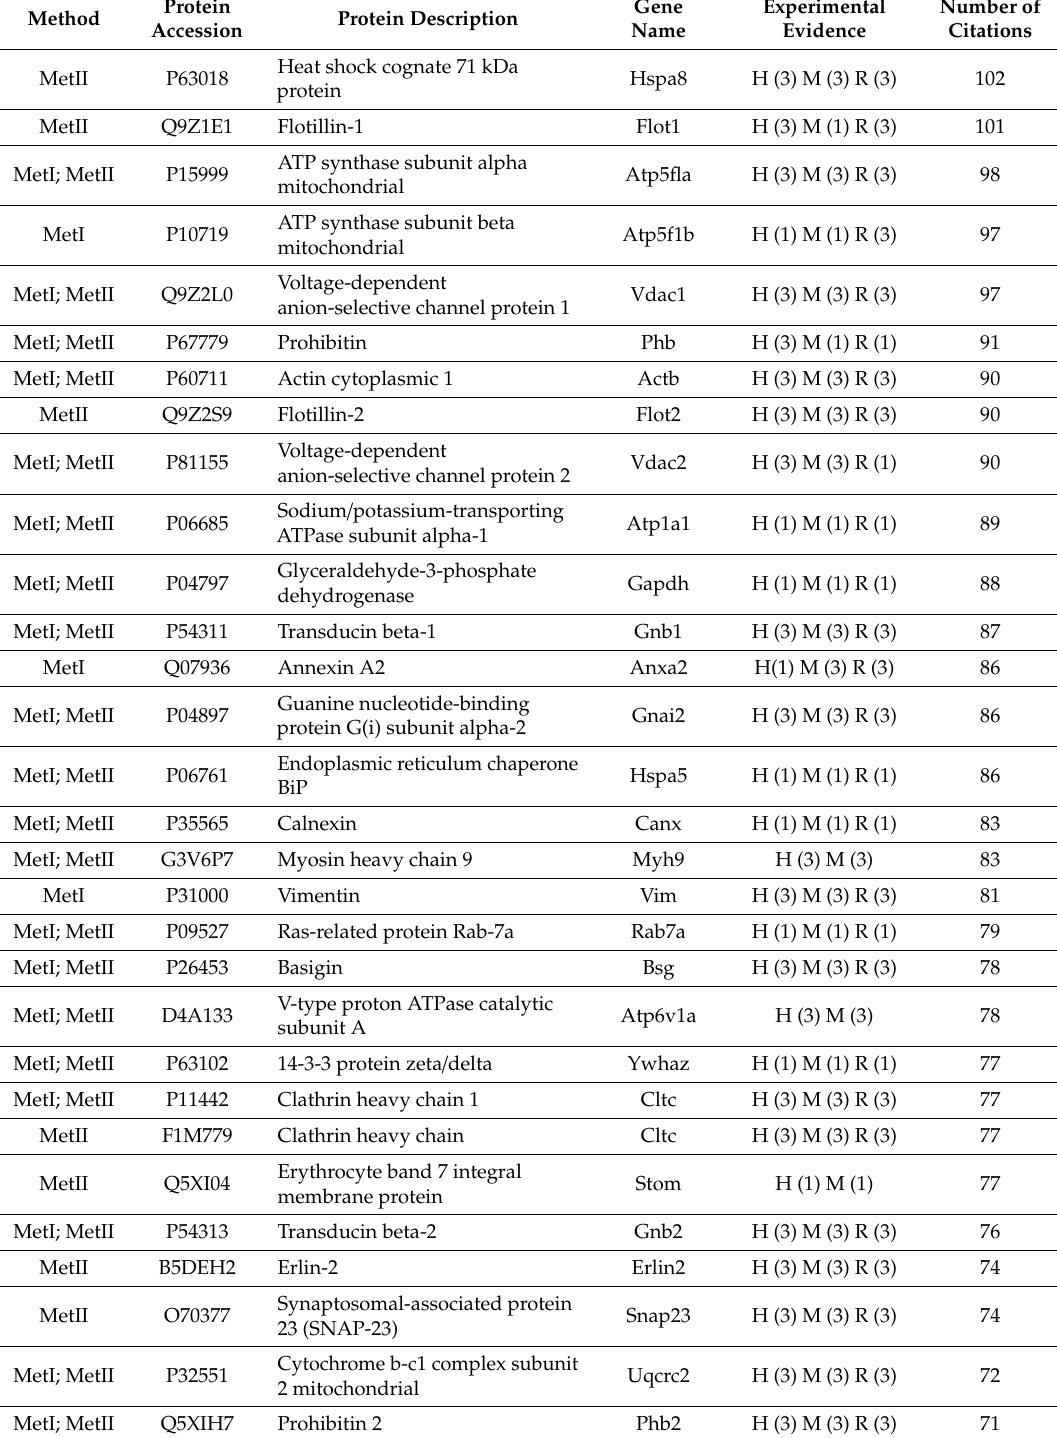
Table 1. Mast cell lipid raft proteins annotated with the highest number of citations supported by experimental evidence in RaftProtV2